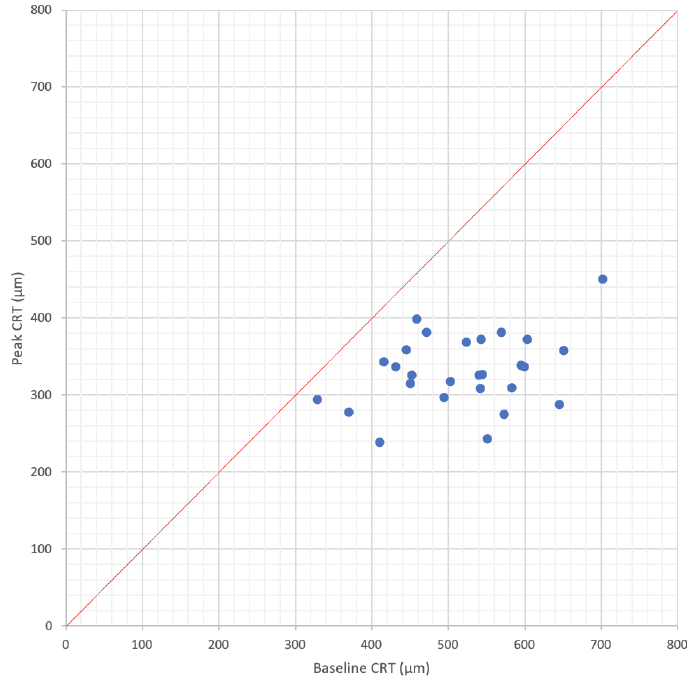
Figure 3. Peak central retinal thickness as a function of baseline central retinal thickness in real-world studies evaluating the efficacy of the fluocinolone acetonide implant for diabetic macular edema. Mean follow-up was 20.3 months ( n = 20 studies).